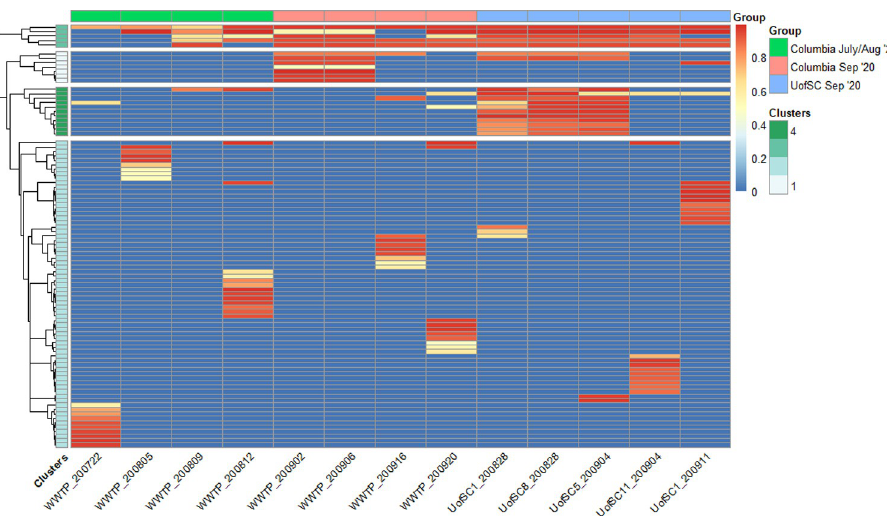
Fig 5. Read frequency of SARS-CoV-2 mutations in Columbia WWTP influent and the University of South Carolina. Each cell represents the read frequency of a mutation from the SARS-CoV-2 reference genome (accession MN908947.3) in wastewater samples from the Columbia WWTP influent (“Columbia”) or the University of South Carolina campus (“UofSC”). Cells in blue indicate the mutation was not observed in the sample. See S2 Fig for complete list of nucleotide mutations corresponding to the heatmap. Only wastewater samples with at least 50% SARS-CoV-2 genome coverage were included in the heatmap.